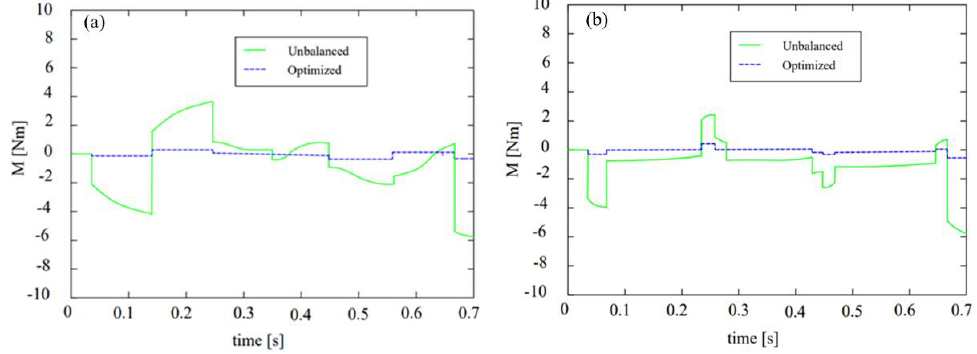
Figure 8. The shaking force of the unbalanced and optimized SPR at ( a ) “low” and ( b ) “high” for trajectory 1.